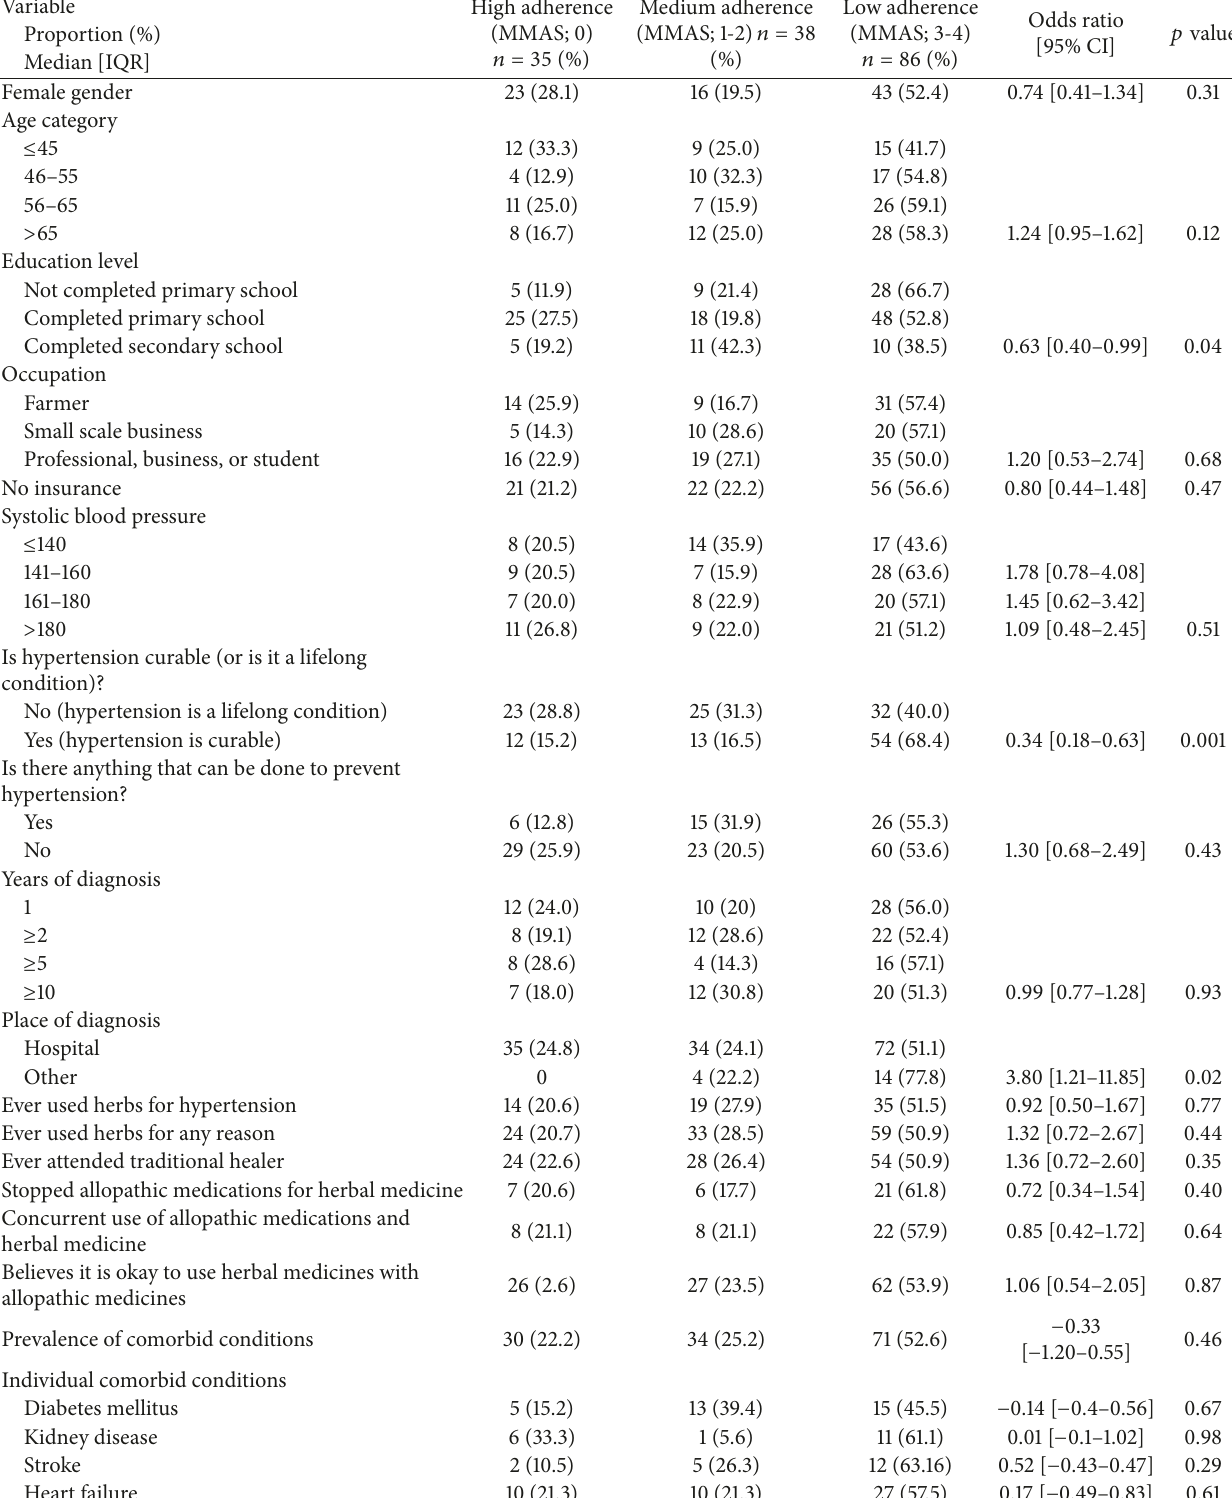
Table 4: Factors associated with medication nonadherence by ordered logistic regression in 213 consecutive adults hospitalized to Bugando Medical Centre with hypertension-related